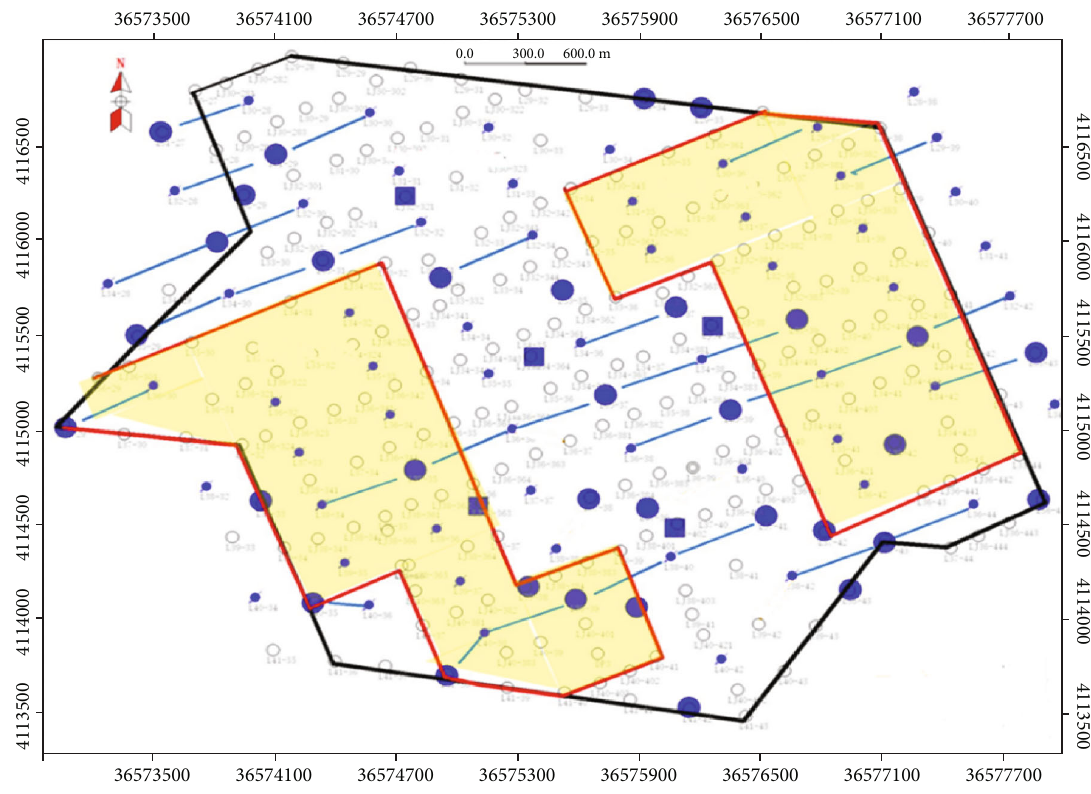
Figure 9: The distribution of WIFs in this